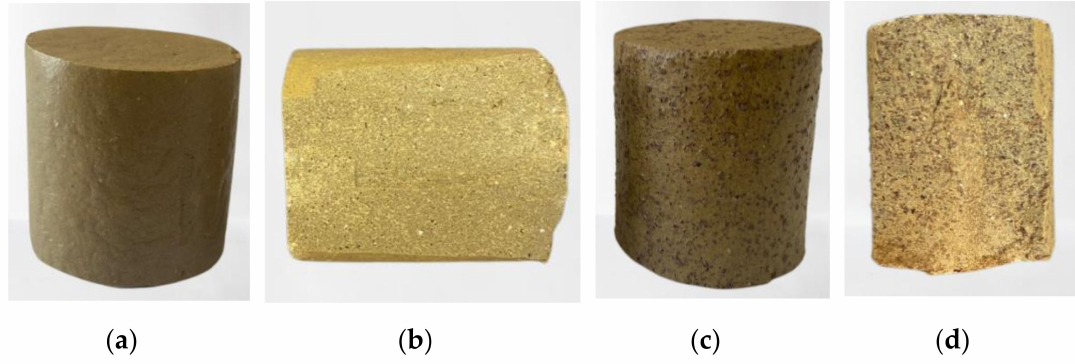
Figure 5. Samples after burning at a temperature of 1170 ◦ C: ( a ) sample based on loam without addi- tive. ( b ) Structure of the sample after the compression test. ( c ) Sample with bentonite. ( d ) Structure of the sample after the compression test.